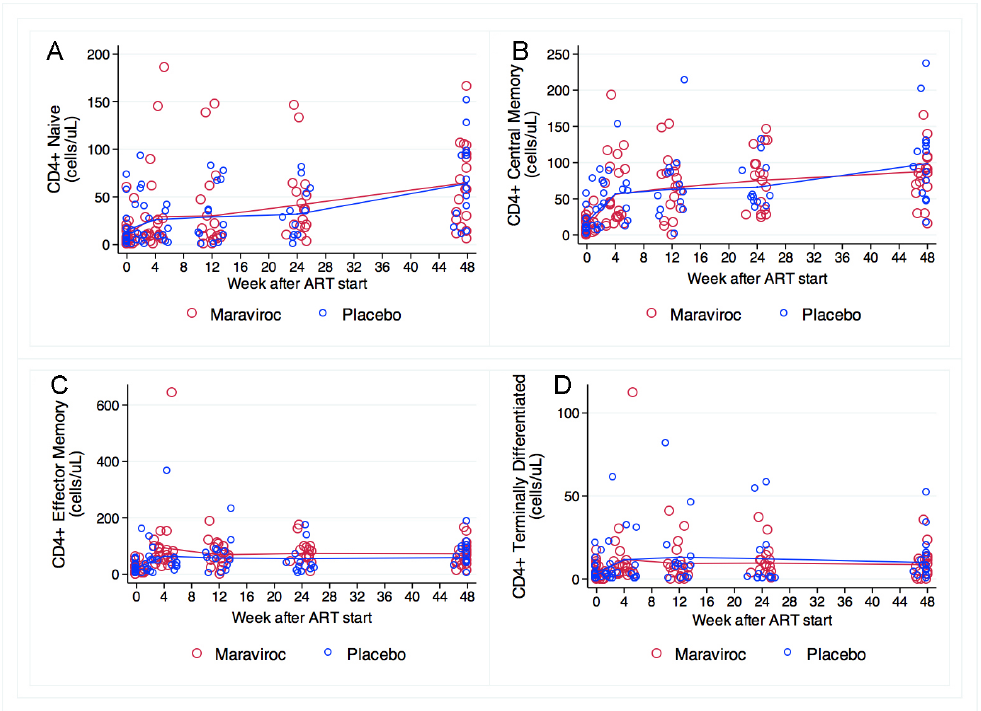
Figure 3. CD4 cell maturation subsets at baseline and weeks 4, 12, 24, and 48. No significant differences between groups at any time point for any CD4 maturation subtypes were observed. (A) Naive and (B) central memory CD4+ cell counts were not different at baseline and increased significantly and in parallel throughout the study in both arms. (C) Effector memory and (D) terminally differentiated CD4+ cells transiently increased in both treatment arms, and remained at similar levels until week 48 in both groups. The scale for the Y-axis differs in these panels. Comparisons of measurements and the rate of change by treatment arm were performed using mixed linear